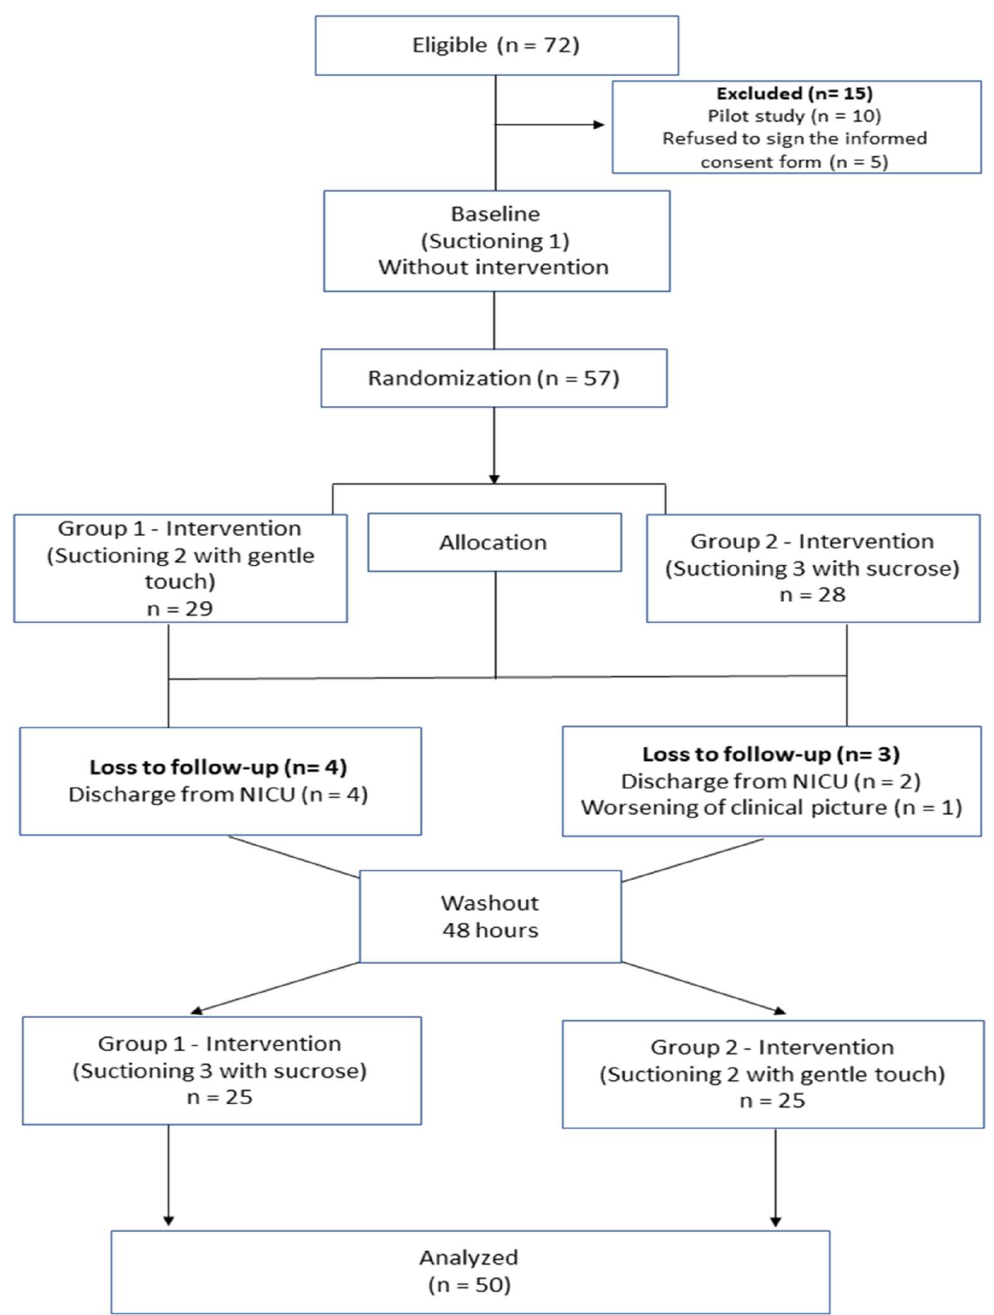
Figure 1. Study flowchart. Adapted from CONSORT 2010: extension to randomized crossover trials.